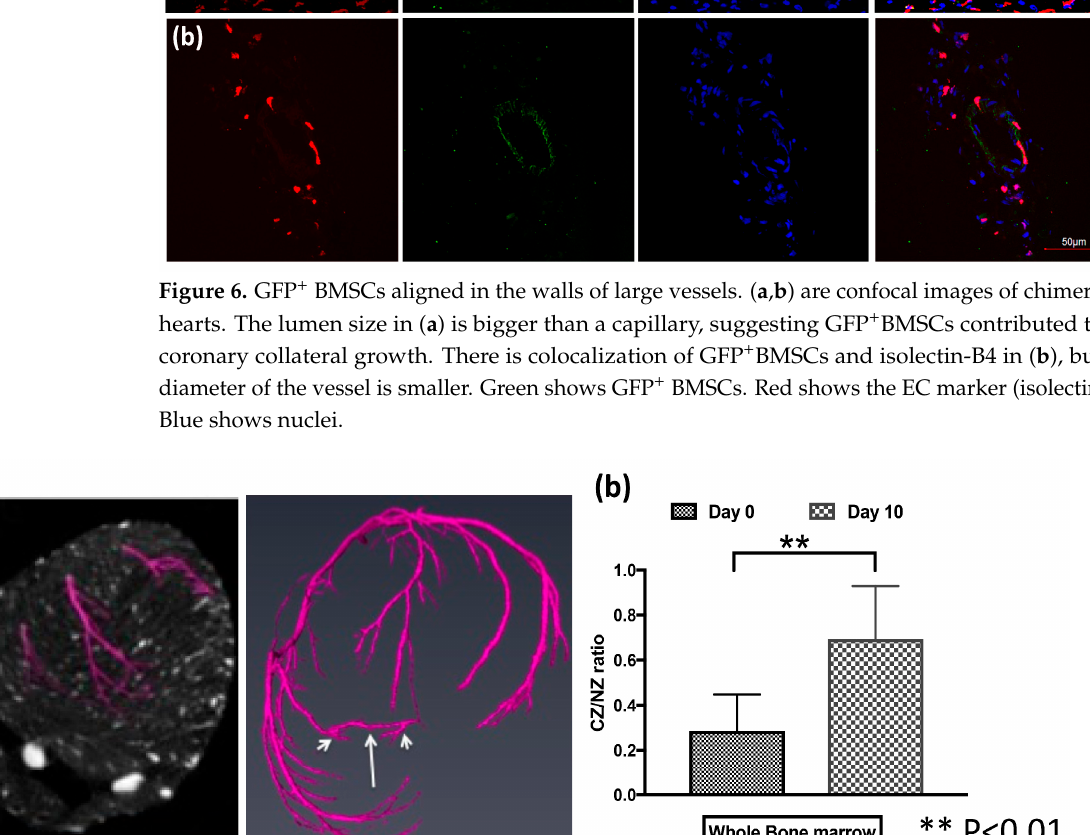
Figure 6. GFP + BMSCs aligned in the walls of large vessels. ( a ) and ( b ) are confocal images of chimeric rat hearts. The lumen size in ( a ) is bigger than a capillary, suggesting GFP + BMSCs contributed to the coronary collateral growth. There is colocalization of GFP + BMSCs and isolectin- B4 in ( b ), but the diameter of the vessel is smaller. Green shows GFP + BMSCs. Red shows the EC marker (isolectin-B4). Blue shows nuclei.